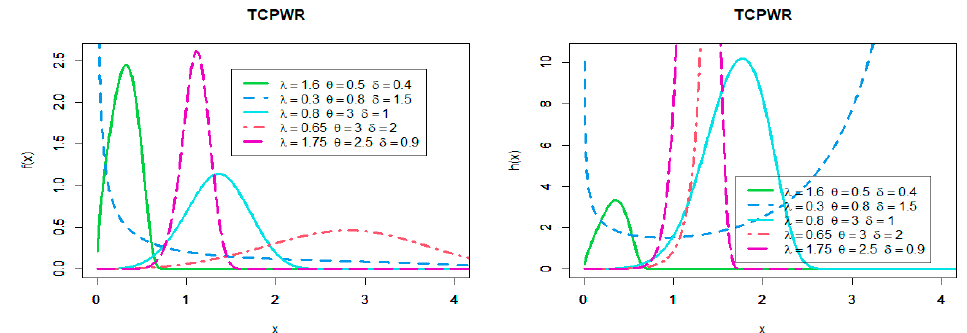
Figure 3. Plots of PDF and the hazard function of TCPWR distribution.